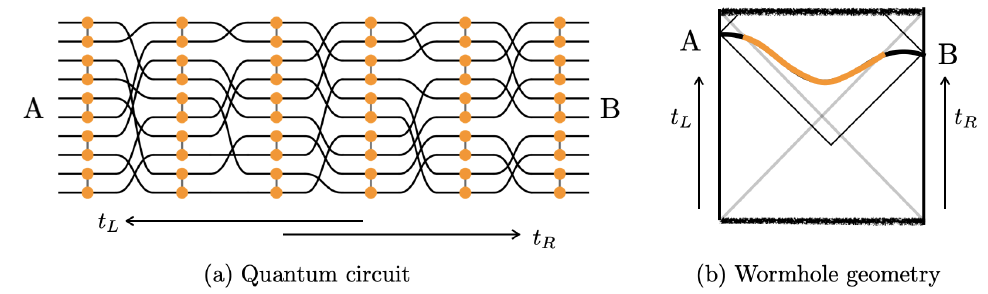
Figure 2 . The size of the wormhole grows as the circuit